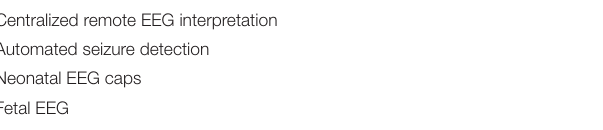
TABLE 2 | Amplitude integrated EEG vs. continuous EEG use.